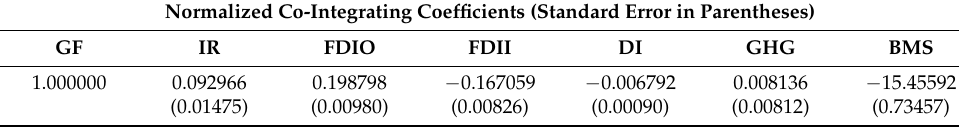
Table 5. Long-run estimation of the